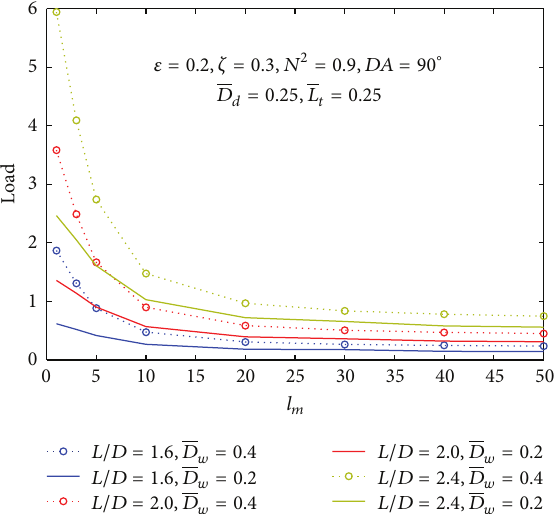
Figure 3: Load variation as a function of characteristics length “ l